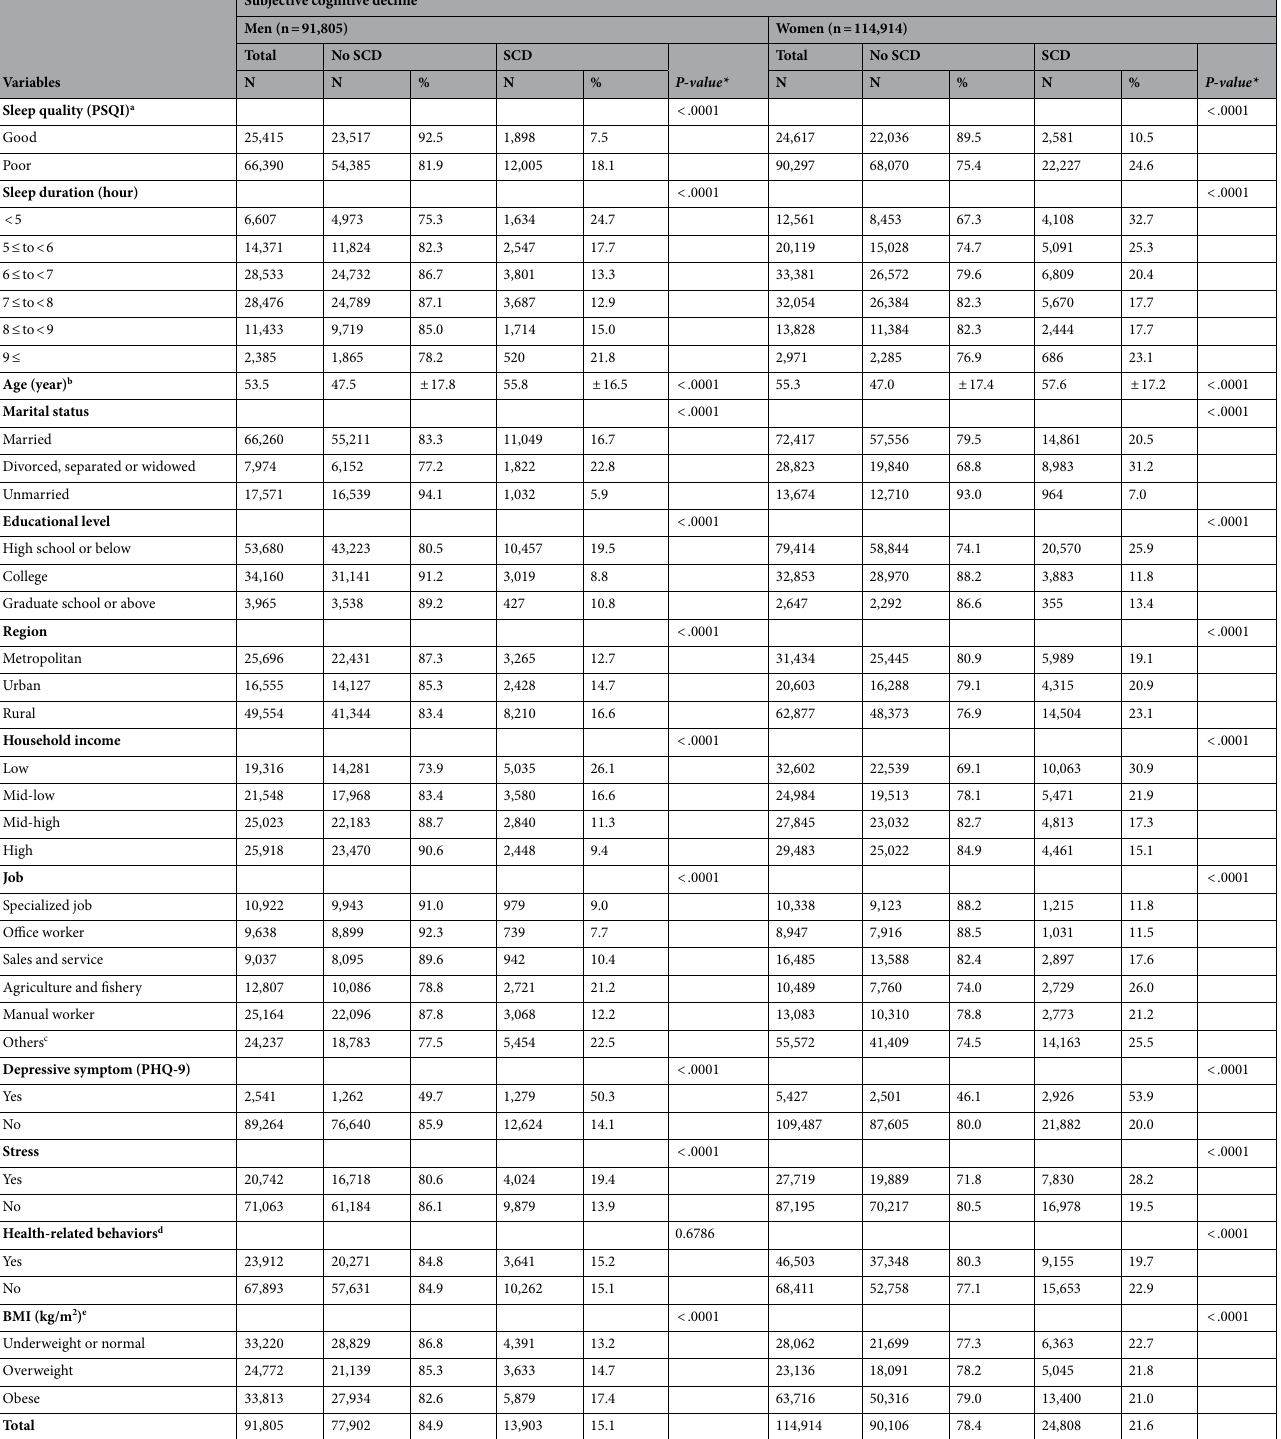
Table 1. General characteristics of the study population. PSQI Pittsburgh Sleep Quality Index, SCD subjective cognitive decline, CI confidence interval, OR odds ratio, PHQ-9 Patient Health Questionnaire-9. a Sleep quality: Sleep quality was measured using the Korean version of Pittsburgh Sleep Quality Index (PSQI-K). Good sleep quality ≤ 5, poor sleep quality > 5. b Values are presented as mean ± standard deviation. c Others: Others include students, housewives, the unemployed and exclude occupational soldiers. d Health-related behaviors: Health- related behaviors include not currently smoking, not high risk alcohol use, and engaging in walking physical activity more than 30 min per day for more than 5 days in the last week. e BMI: body mass index; Obesity status defined by BMI based on 2014 Clinical Practice Guidelines for Overweight and Obesity in Korea. *P-values were obtained by t-test or Chi-square